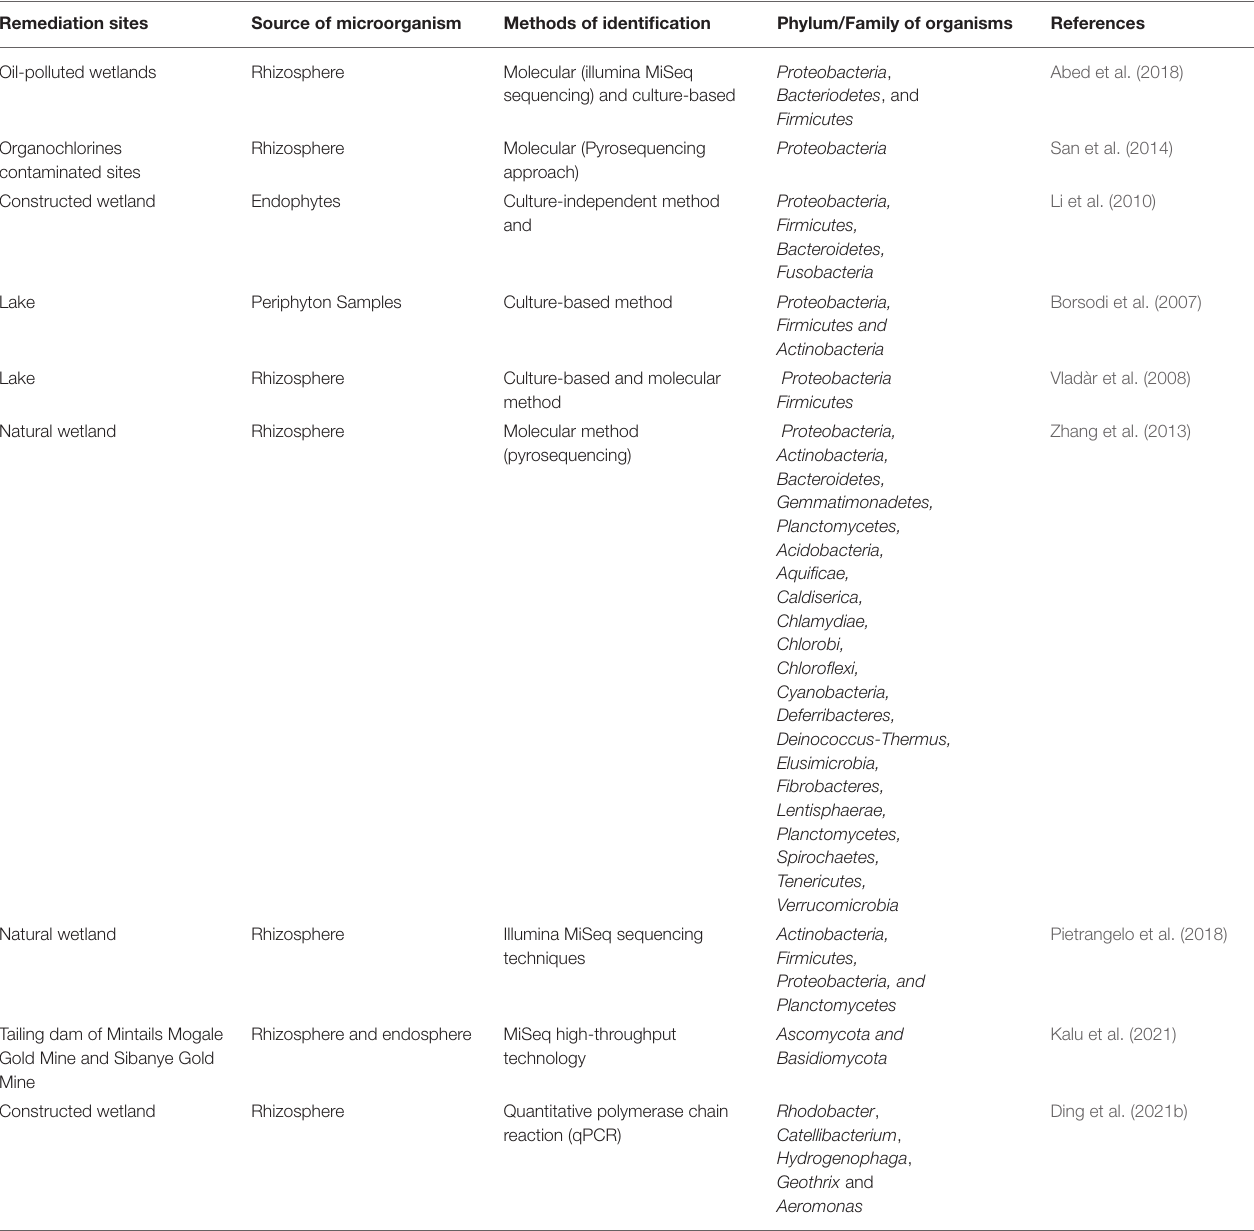
TABLE 1 | Summary of the microbial spectra associated with P. australis in the remediation of polluted